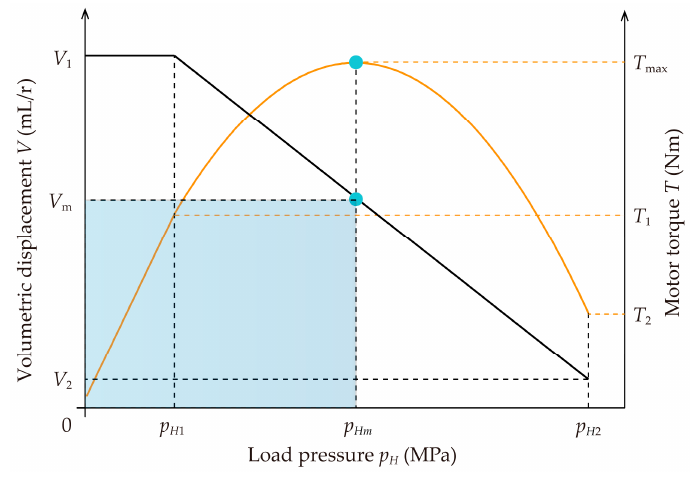
Figure 1. Schematic diagram of an electro-hydrostatic actuator (EHA) system with load-sensing pump.